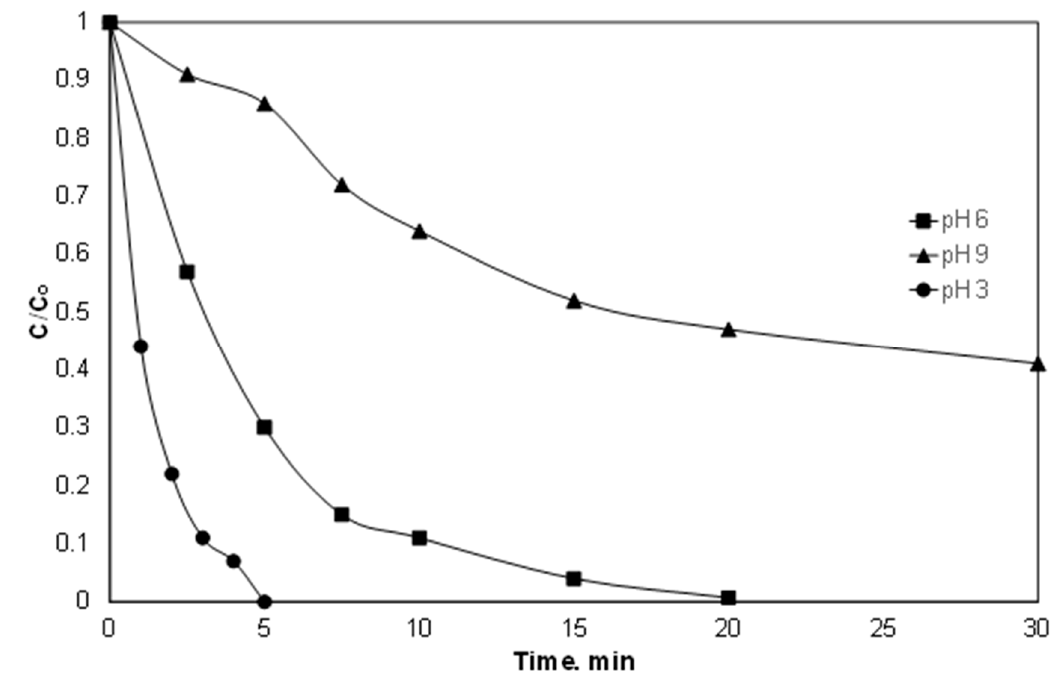
Figure 3. Effect of pH on the degradation of PIR. [PIR] = 500 µ g/L, [Fe 2+ ] = 2 mg/L, [SPS] = 20 mg/L, ultrapure water and inherent pH.